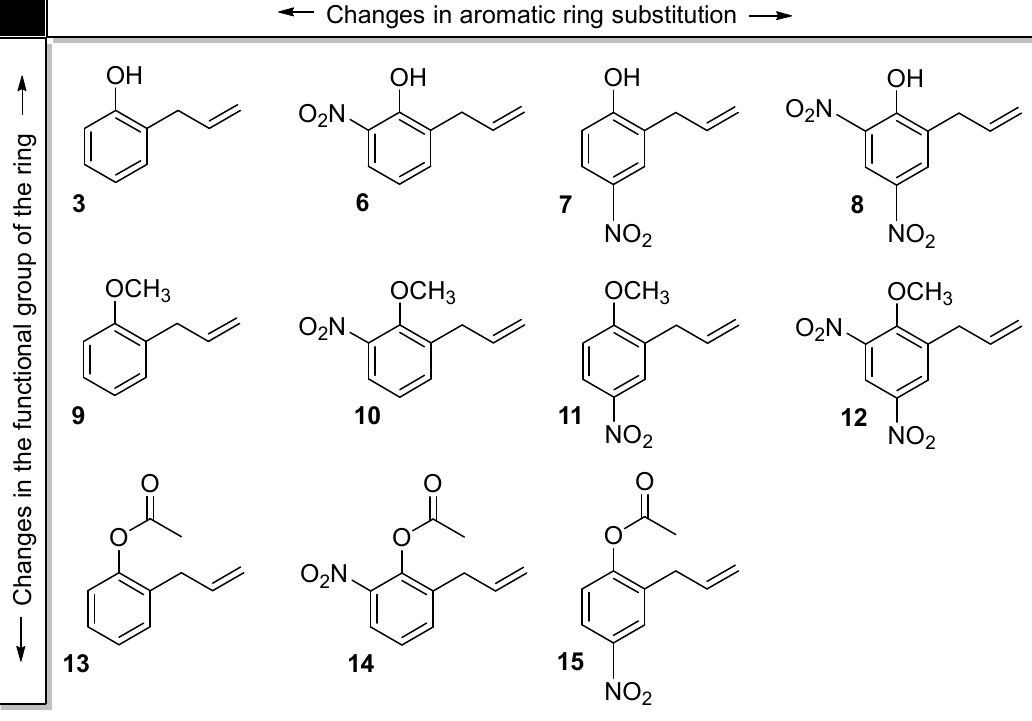
Figure 2. Chemical structure of 2-allylphenol ( 3 ) and its derivatives ( 6 – 15 ), used in this study. All derivatives, except 1-allyl-2-methoxy-5-nitrobenzene ( 11 ), have been previously synthesized and characterized by spectroscopic methods [45]. Compound ( 11 ) was ob- tained with an 89% yield by reacting ( 7 ) with dimethyl sulfate.